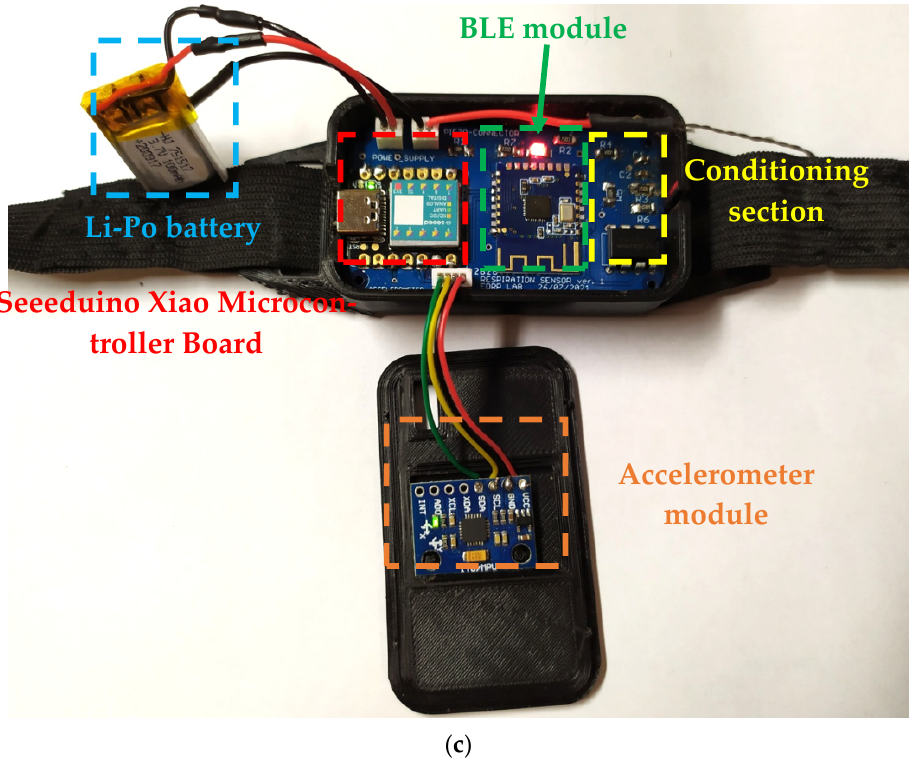
Figure 4. Front ( a ) and back ( b ) views of the developed piezoresistive band. Electronic sensing and conditioning with highlighting of the main components and modules ( c ).